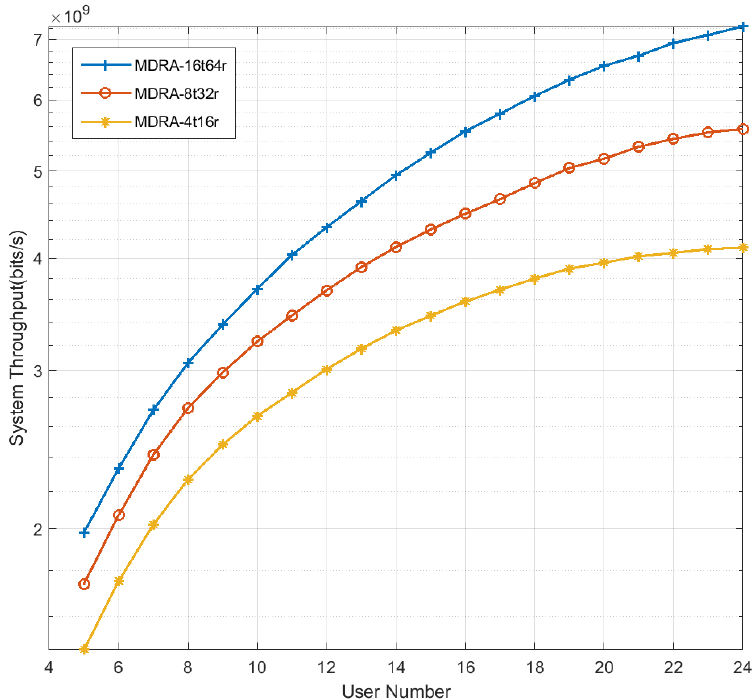
Figure 9. The system throughput with different number of N t and N r